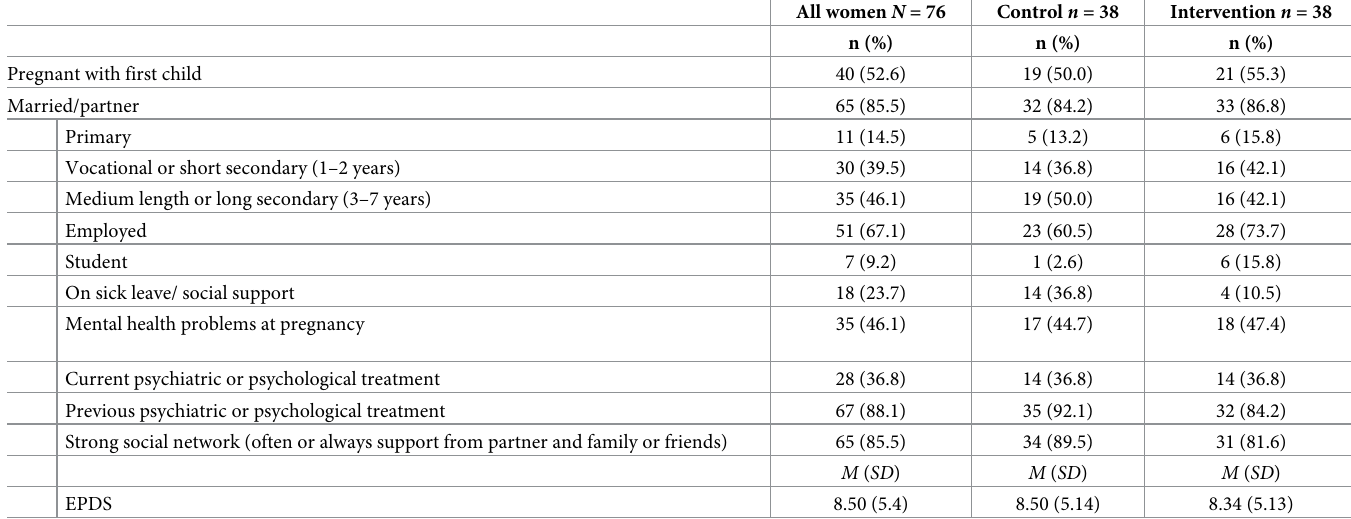
Table 2. Participant